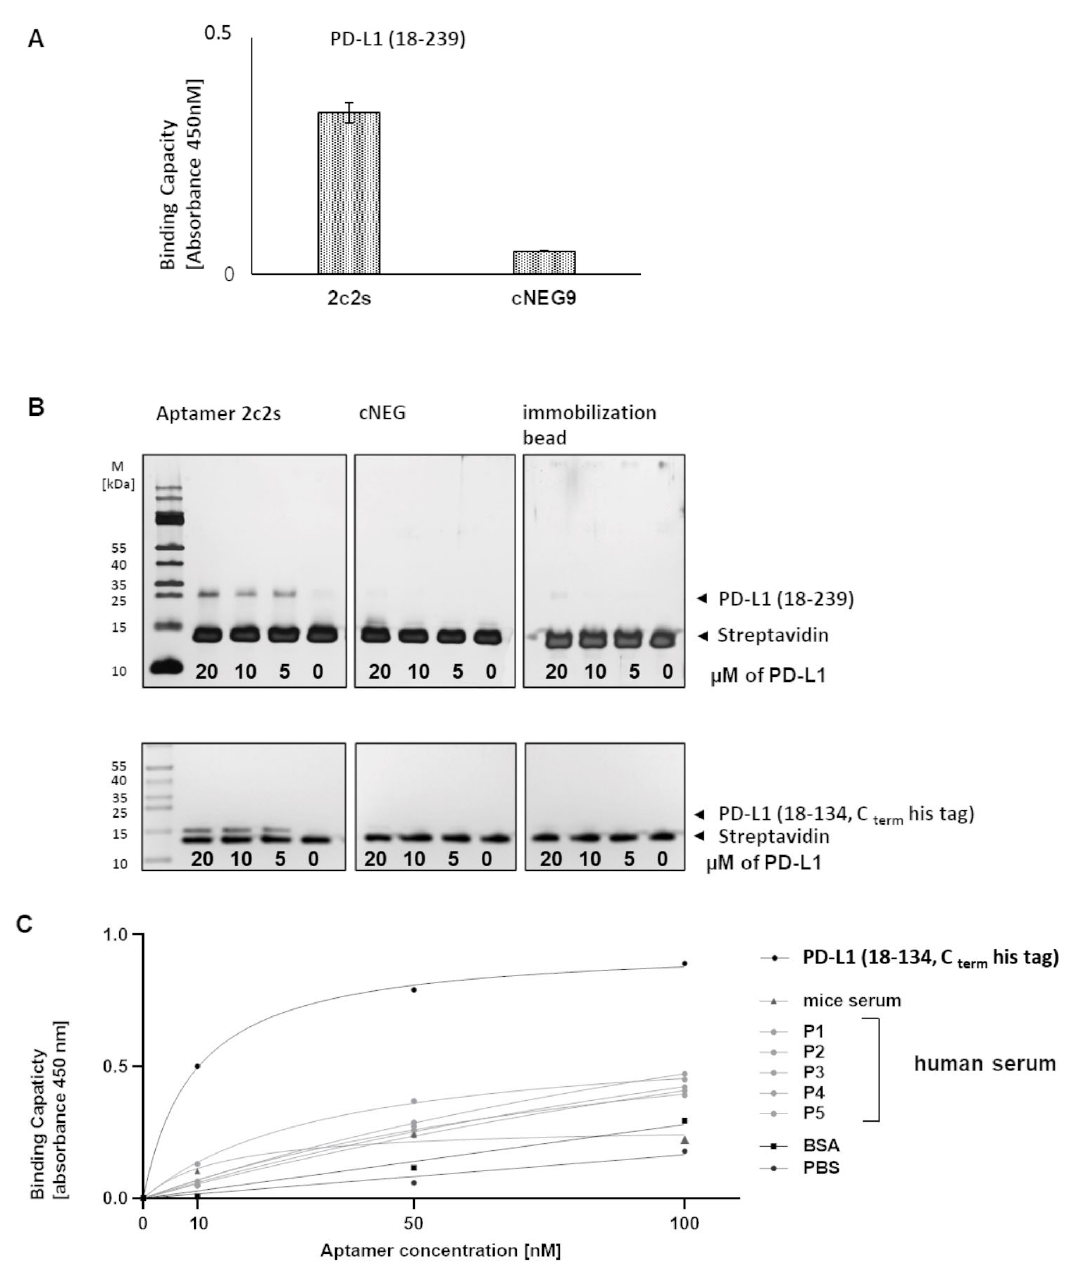
Figure 3. The binding capacity of 2c2s to PD-L1. ( A ) ELISA mediated detection of aptamer bound to immobilized PD-L1; ( B ) protein immobilization assay. Indicated, biotinylated aptamers were immobilized on streptavidin-coated beads and retention of PD-L1 was assessed by SDS-PAGE. ( C ) ELISA mediated detection of 2c2s interaction with indicated protein coated surface.